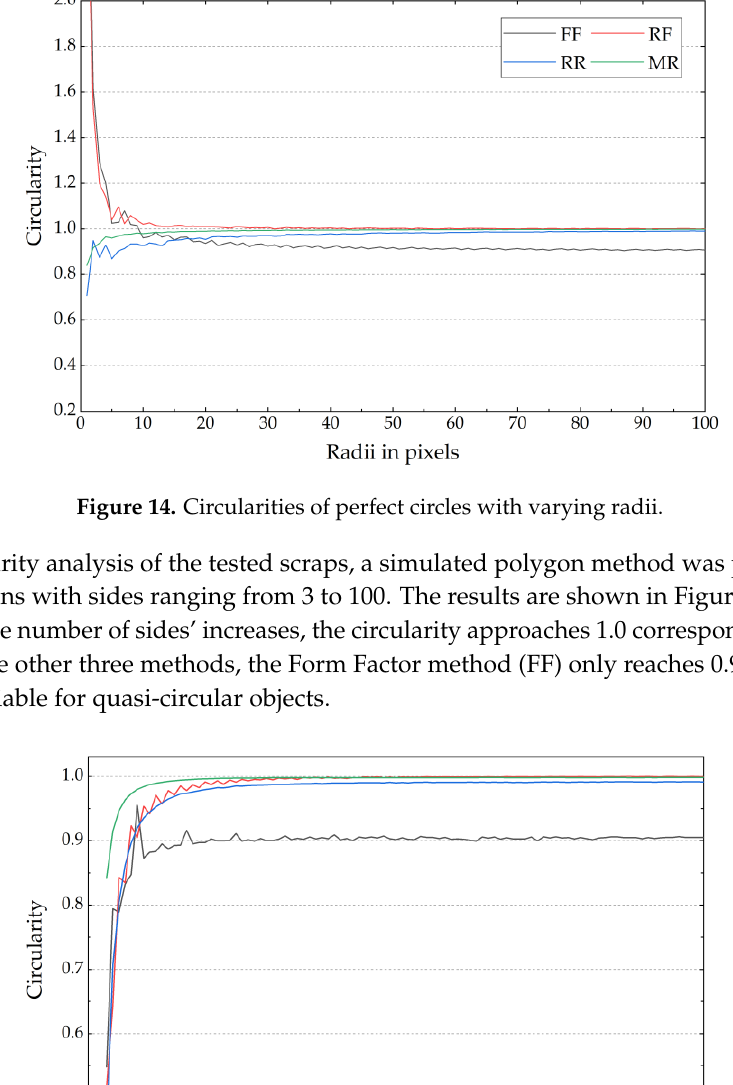
( d ) Figure 13. Bar plots of measurement results: ( a ) Form Factor; ( b ) Roundness Factor; ( c ) Radius Ratio; and, ( d ) Mean Roundness. In order to analyze the precision of the four methods in this research, perfect circles were